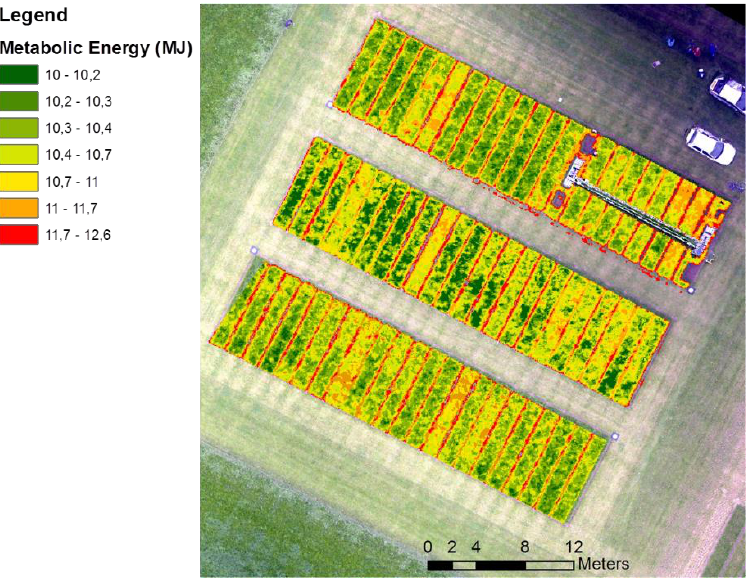
Figure 10. Metabolic energy variation within plots by applying the CI red-edge index on the acquired hyperspectral dataset of